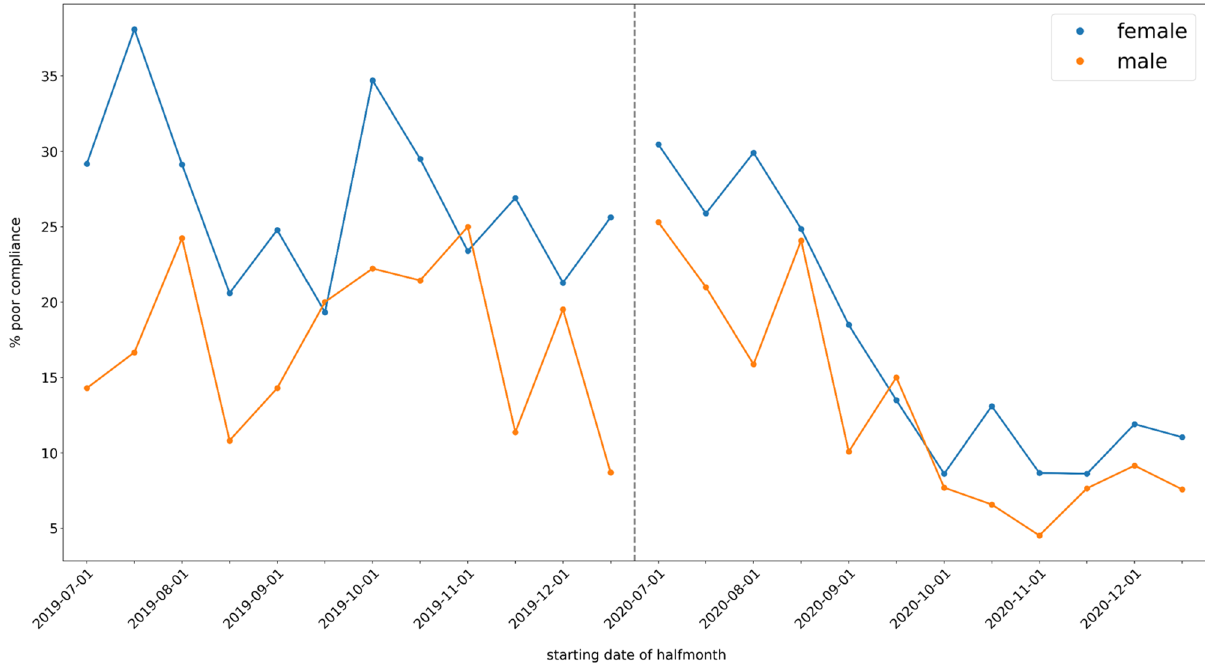
Figure 3. Mean poor compliance by starting date of treatment, split by gender. The dashed vertical line indicates the gap between the two segments.